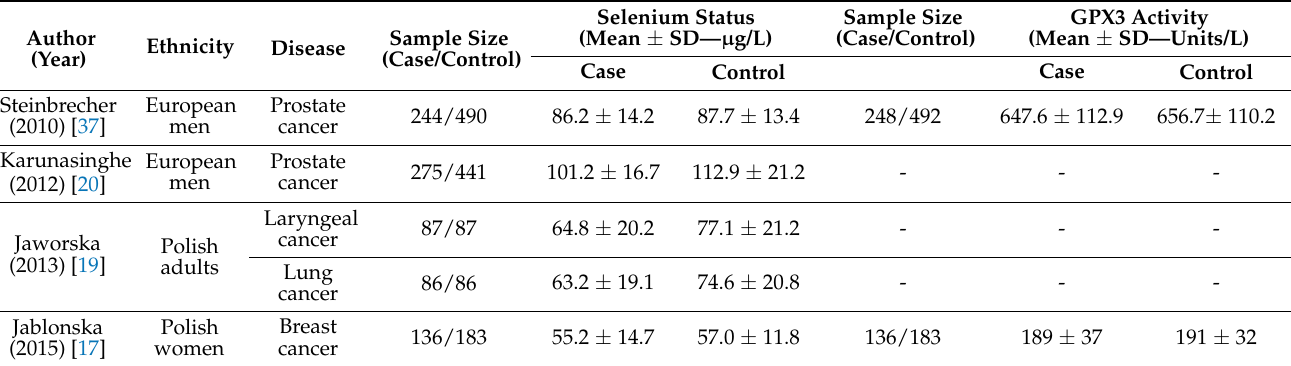
Table 2. Selenium and GPX3 activity levels reported in this systematic review and